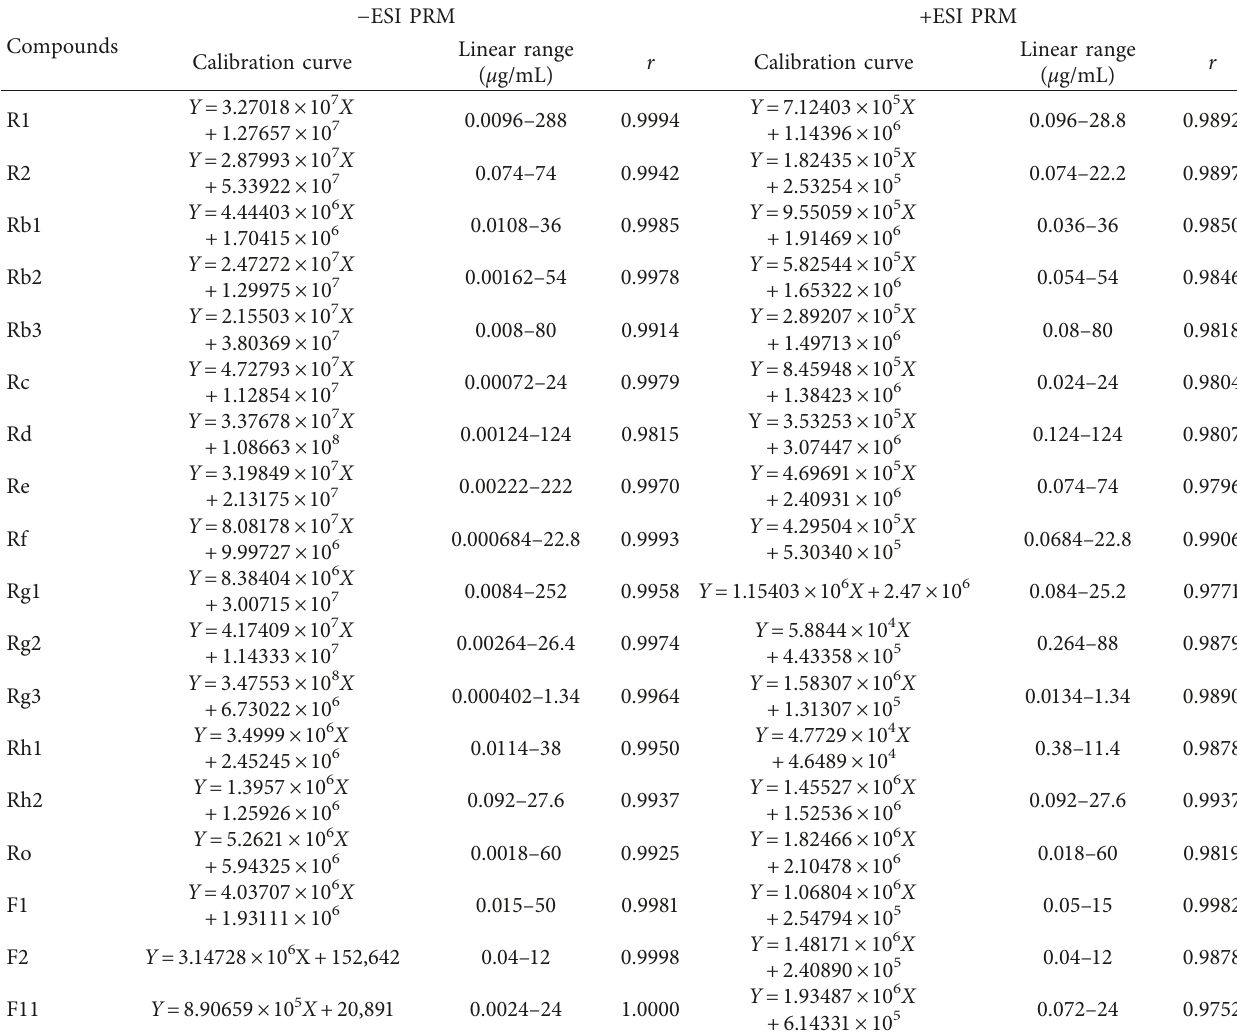
Table 6: Calibration curve for the eighteen ginsenosides in ginseng stem-leaf.